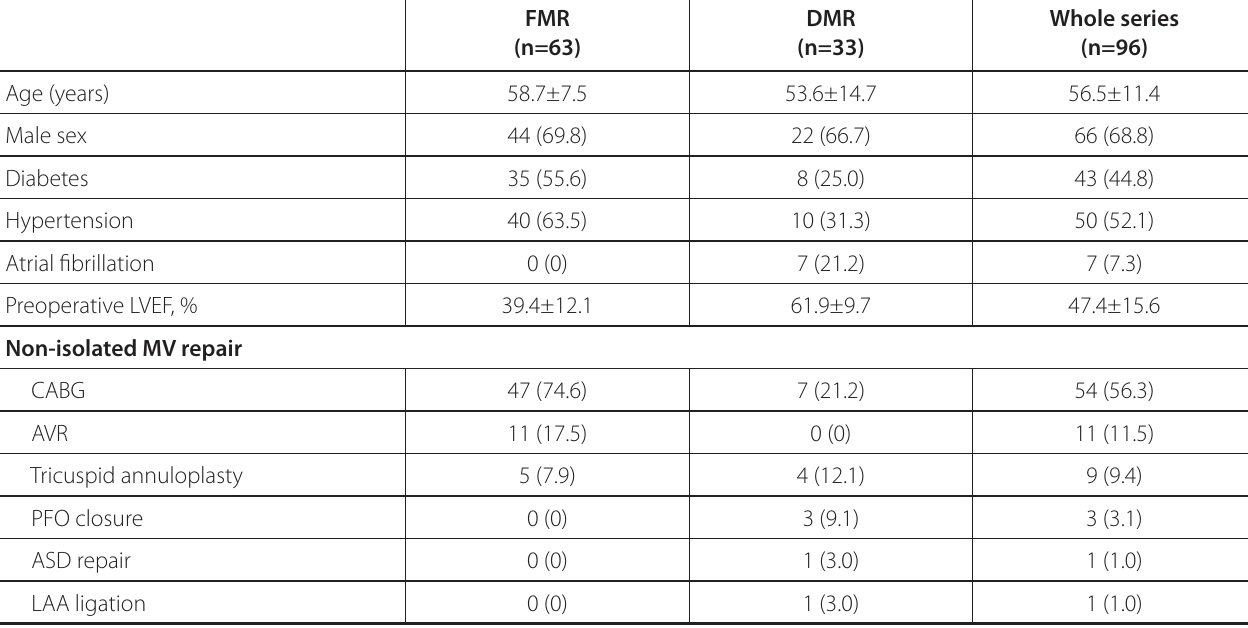
Table 1 . Patients’